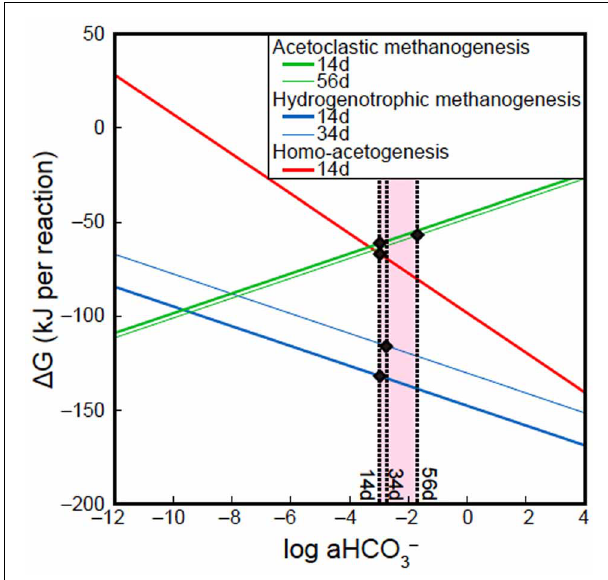
FIGURE 10 | Effects of HCO − 3 activity (a HCO − 3 ) on (cid:3) G of acetoclastic methanogenesis, hydrogenotrophic methanogenesis and homo-acetogenesis. All lines in figure were calculated using geochemical data of samples 14d, 34d, and 56d, except Dissolved inorganic carbon (DIC) concentrations. Solid circles indicate (cid:3) G of acetoclastic methanogenesis, hydrogenotrophic methanogenesis and homo-acetogenesis at the DIC concentrations examined in this